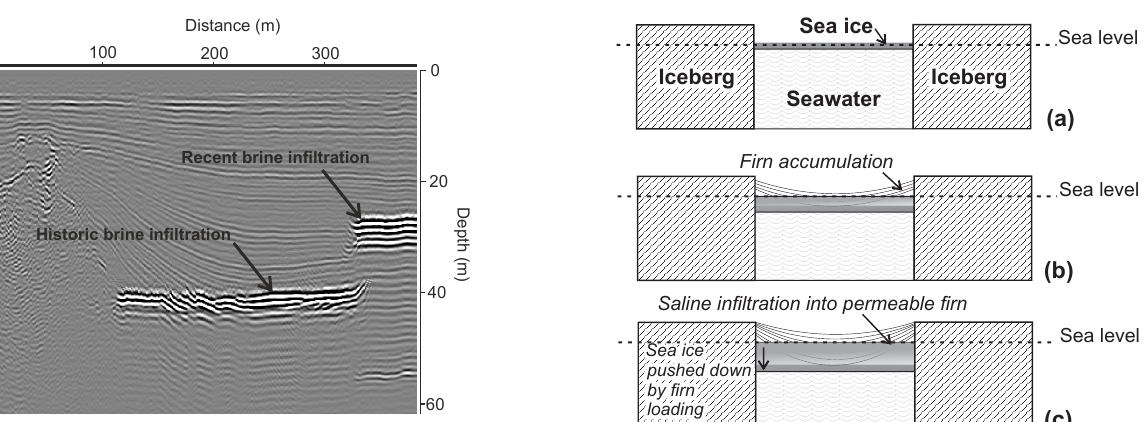
Figure 9. Illustration of the process by which sea ice between ice- bergs becomes loaded by firn accumulation and is driven below sea level by hydrostatic adjustment, allowing seawater to soak into the porous and permeable firn from